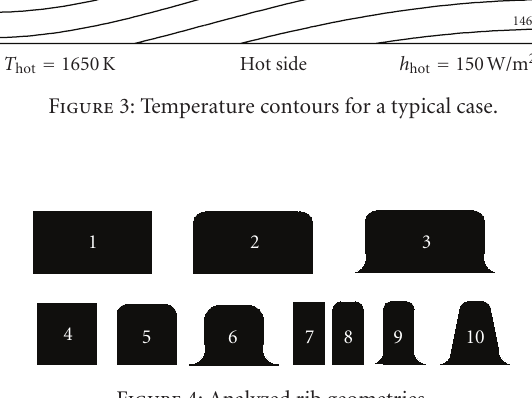
Figure 4: Analyzed rib geometries.